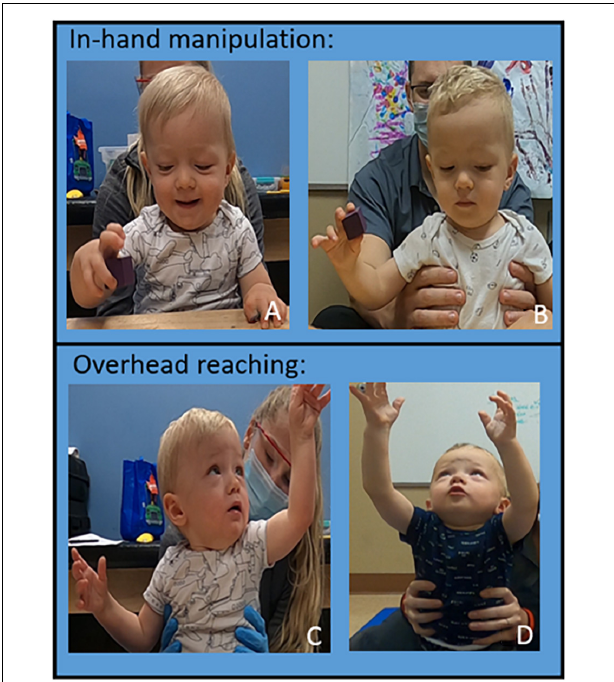
FIGURE 5 | Upper Extremity Progression. In hand manipulation progression. (A) Session 40: inappropriate kinematics of digits two and three performing in-hand manipulation. (B) Session 140: appropriate kinematics of digits two and three performing in-hand manipulation independently. Overhead reaching progression: (C) Session 40. The patient can fully flex his elbow, pronate the forearm without shoulder abduction, and able to flex his shoulder greater than 90 ◦ with appropriate kinematics and trunk support at inferior scapula. (D) Session 160 the patient flexes his shoulder fully to reach overhead with appropriate kinematics and decreased trunk support (low